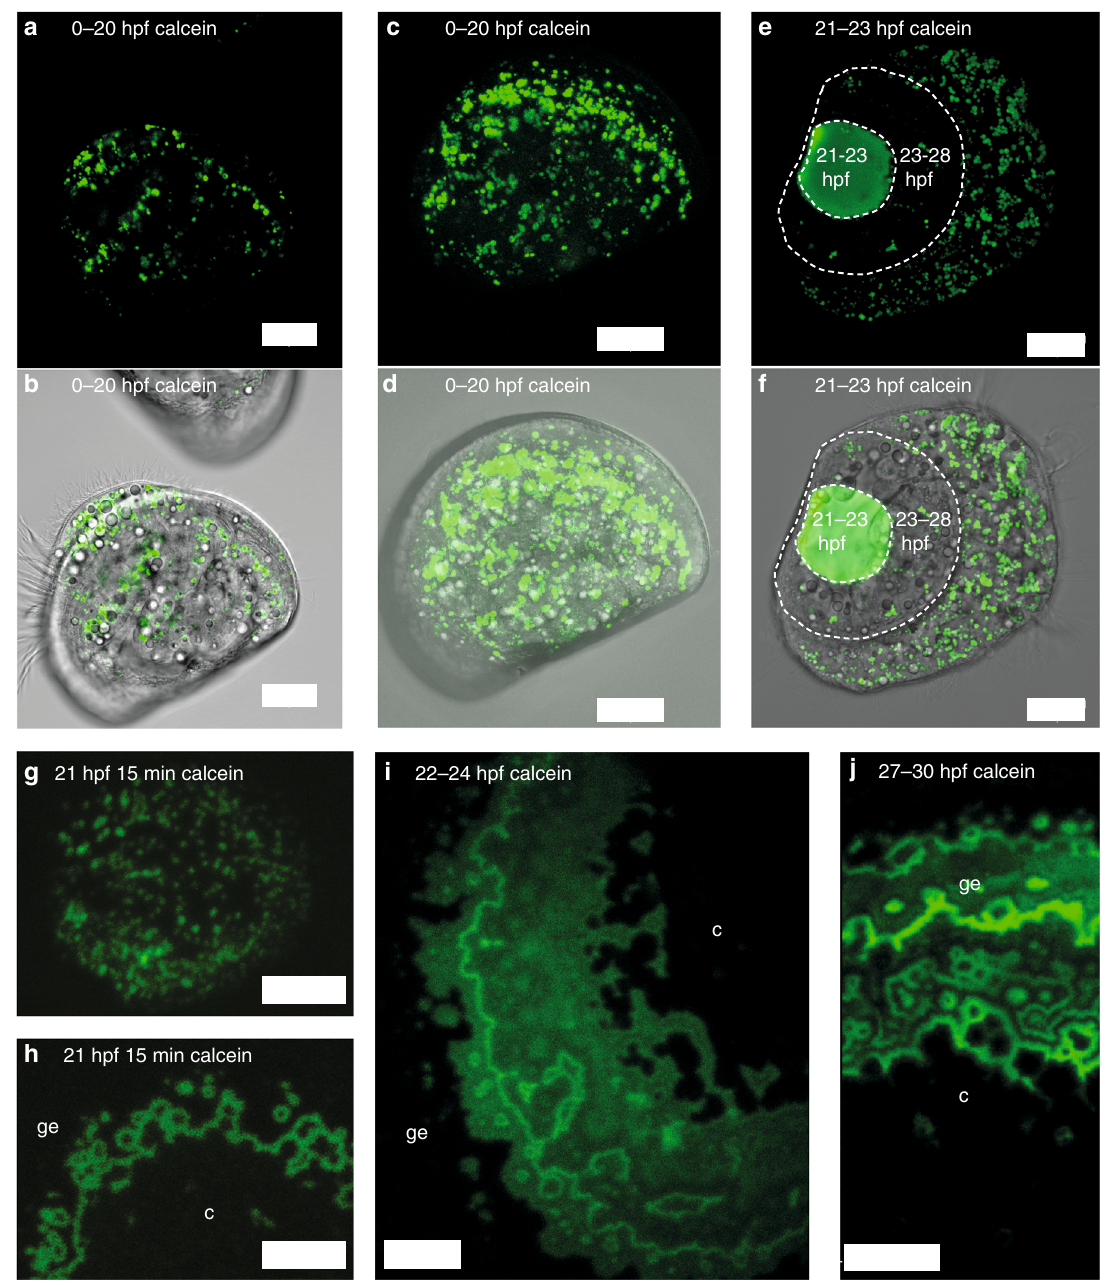
Fig. 2 Calcein pulse-chase experiments and in vivo confocal microscopy from Exp 2. a , b Calcein fl uorescence image and merged fl uorescence and transmission images of larva cultured in calcein between 0 – 20hpf, followed by development in fi ltered seawater (FSW) until 48hpf, 1 μ m thick section through body and shell to illustrate lack of calcein fl uorescence in the shell. c , d Same animal, confocal projection through one entire shell valve and body to illustrate numerous calcein positive intracellular vesicles yet no fl uorescence in the shell. e , f Confocal projection of calcein fl uorescence of larva cultured in calcein FSW between 21 – 23hpf. Shell material formed between 21 – 23hpf is calcein labeled, shell material formed between 23 – 28hpf is not. Calcein label of vesicles present at 28hpf has apparently not been transferred into the shell. g , h 21hpf animals stained with calcein for 15min, then washed and cultured in FSW, calcein positive particles on periostracum g , shell growth bands in a slightly more advanced larva from the same fertilization h . i Confocal projection of shell calcein fl uorescence of larva cultured in seawater with calcein pulse between 22 – 24hpf. j Confocal projection of shell calcein fl uorescence of larva cultured in seawater with calcein pulse between 27 – 30 hpf. c = centre of shell valve, ge = growing edge of shell valve. Scale bars: 20 µ m a – f , 5 µ m h , i , 10 µ m